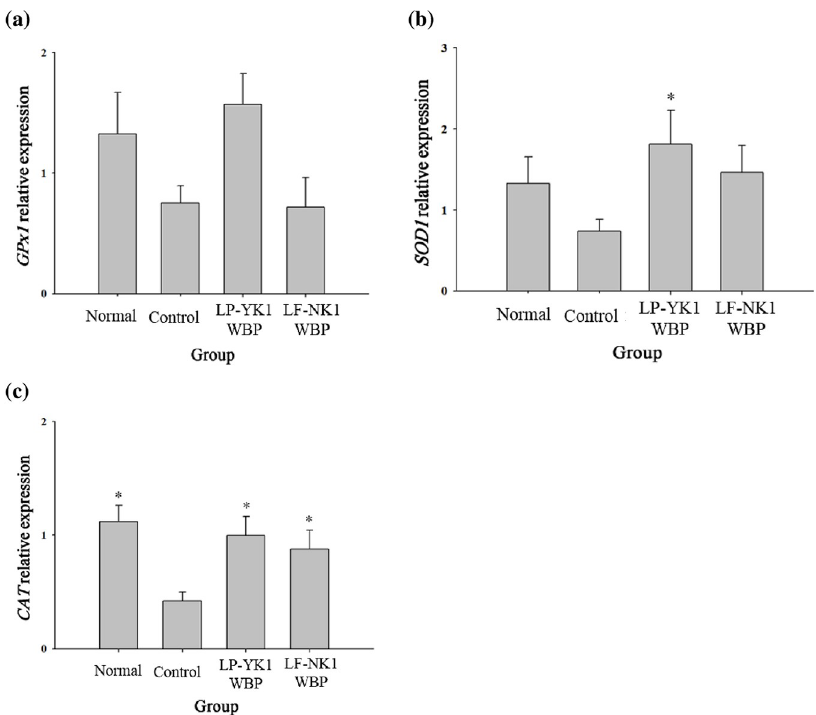
Fig 4. Relative expression of oxidative stress cytokines in gingival tissue after treatment of fermented whey bioconversion products (WBPs) for 8 weeks. (a) Gpx1 (b) Sod1 (c) Cat . Normal: Administration of phosphate buffered saline (PBS) without inducing periodontitis, Control: Administration of PBS after inducing periodontitis, LP-YK1 WBP: Administration of whey bioconversion product by L . plantarum SMFM2017-YK1 after inducing periodontitis, LF-NK1 WBP: Administration of whey bioconversion product by L . fermentum SMFM2017-NK1 after inducing periodontitis. � Statistically significant, compared to control group by pairwise Student’s t -test ( p < 0.05).